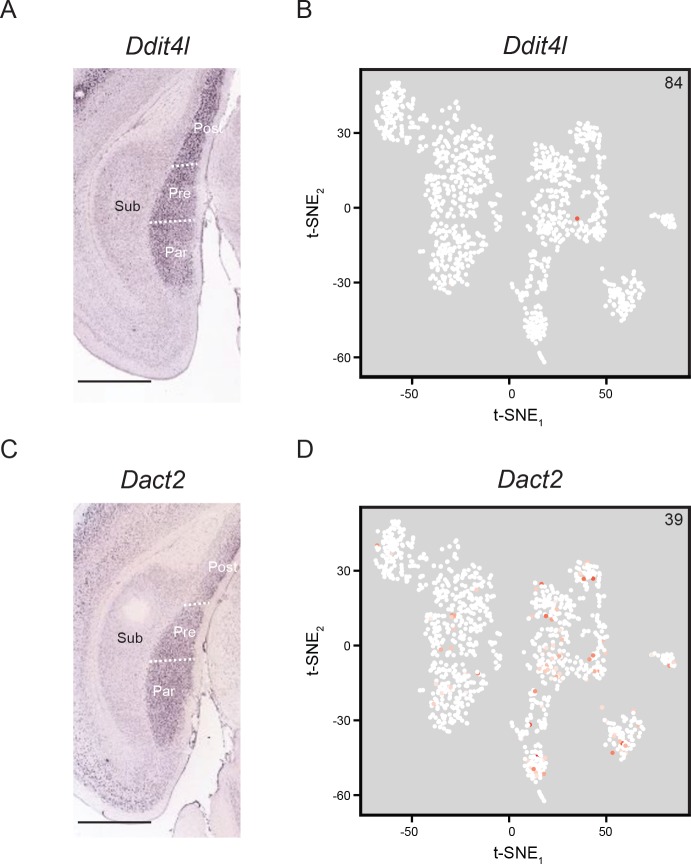
No clusters are associated with genes expressed in parasubiculum, presubiculum, or postsubiculum.(A) ISH image illustrating expression of Ddit4l in parasubiculum (‘Para’), presubiculum (‘Pre’), and postsubiculum (‘Post’), but not subiculum (‘Sub’). Scale bar: 1 mm. B. Ddit4l is generally not expressed in the scRNA-seq dataset. Inset value denotes maximum CPM in dataset. C,D. As in (A,B), but for the gene Dact2. Scale bar: 1 mm.